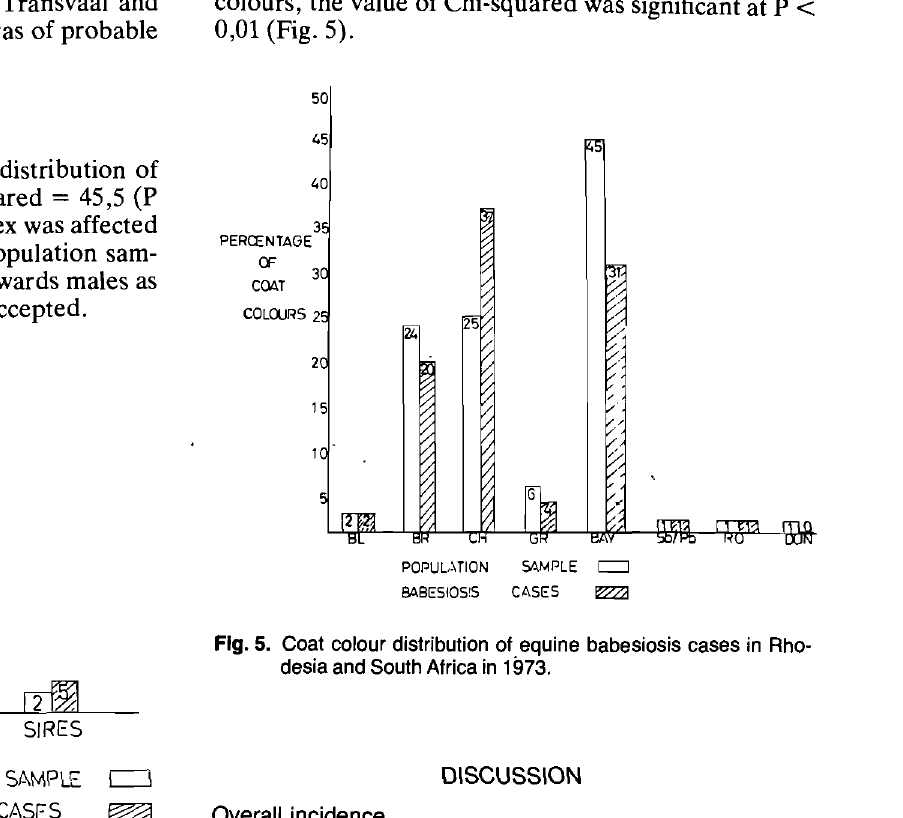
Fig. 3. Sex distribution of cases of equine babesiosis.